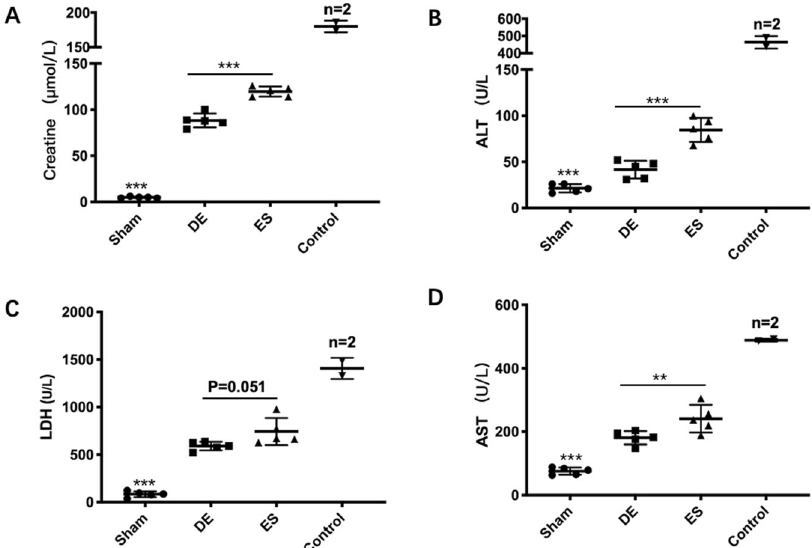
Fig. 2 De-escalation strategy alleviates organ injuries in the late sepsis stage. A – D The serum levels of the AST, creatine, ALT, and LDH were measured with an ELISA kit in all groups ( n = 17). The levels of blood chemistries were lower in the DE group than those in the ES group ( p < 0.01). However, those were extremely higher in the control group though there were only 2 of 10 left on day 6. DE de-escalation. ES